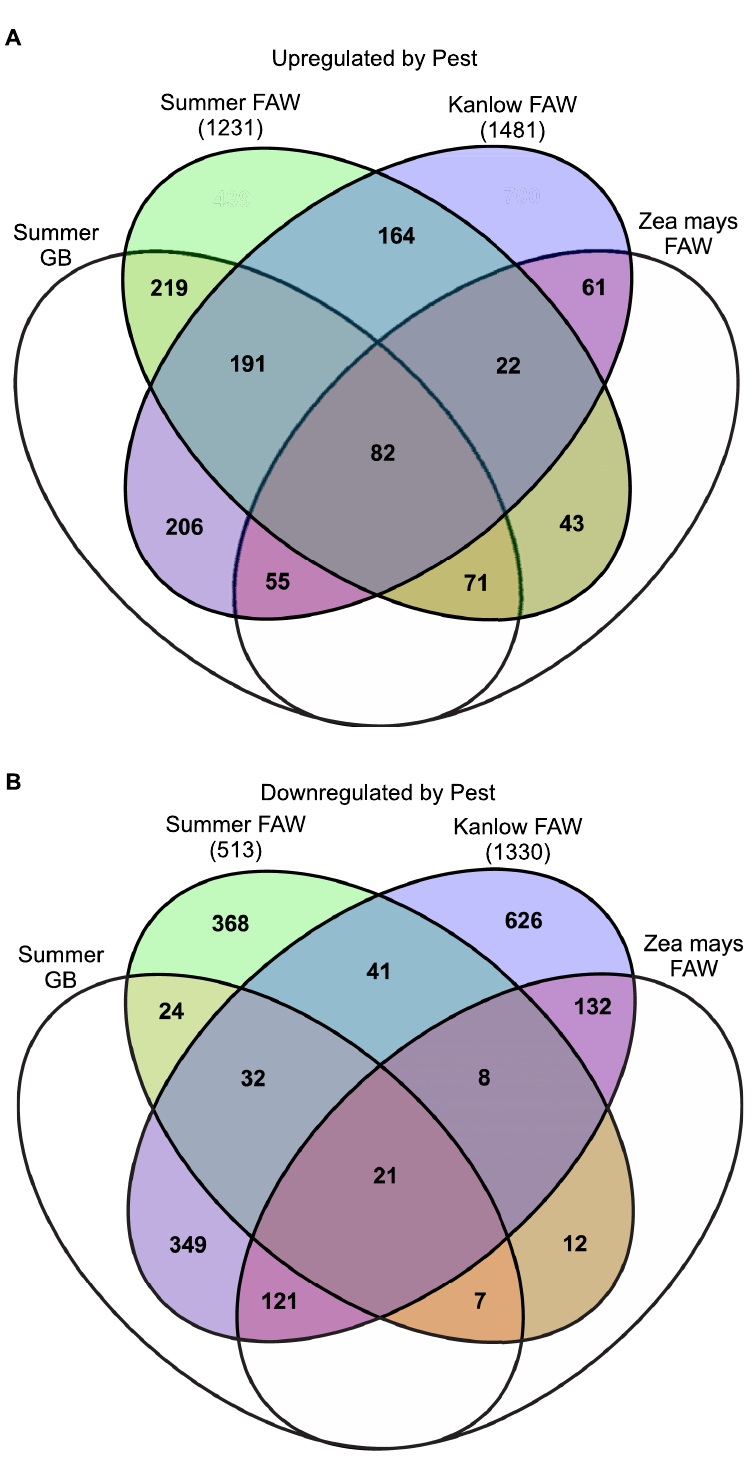
Fig 4. Meta-analysis of genes induced by insect pests. Venn diagrams showing the overlap of DEGs in this study compared to DEGs identified in Donze-Reiner et al. [25] resulting from GB feeding on Summer switchgrass and switchgrass orthologs to DEGs identified in Tzin et al. [37] resulting from FAW feeding on Zea mays after 24 hours.